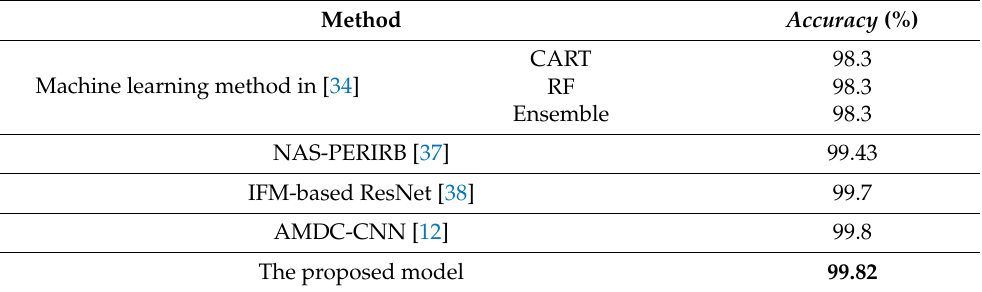
Table 7. Accuracy of existing